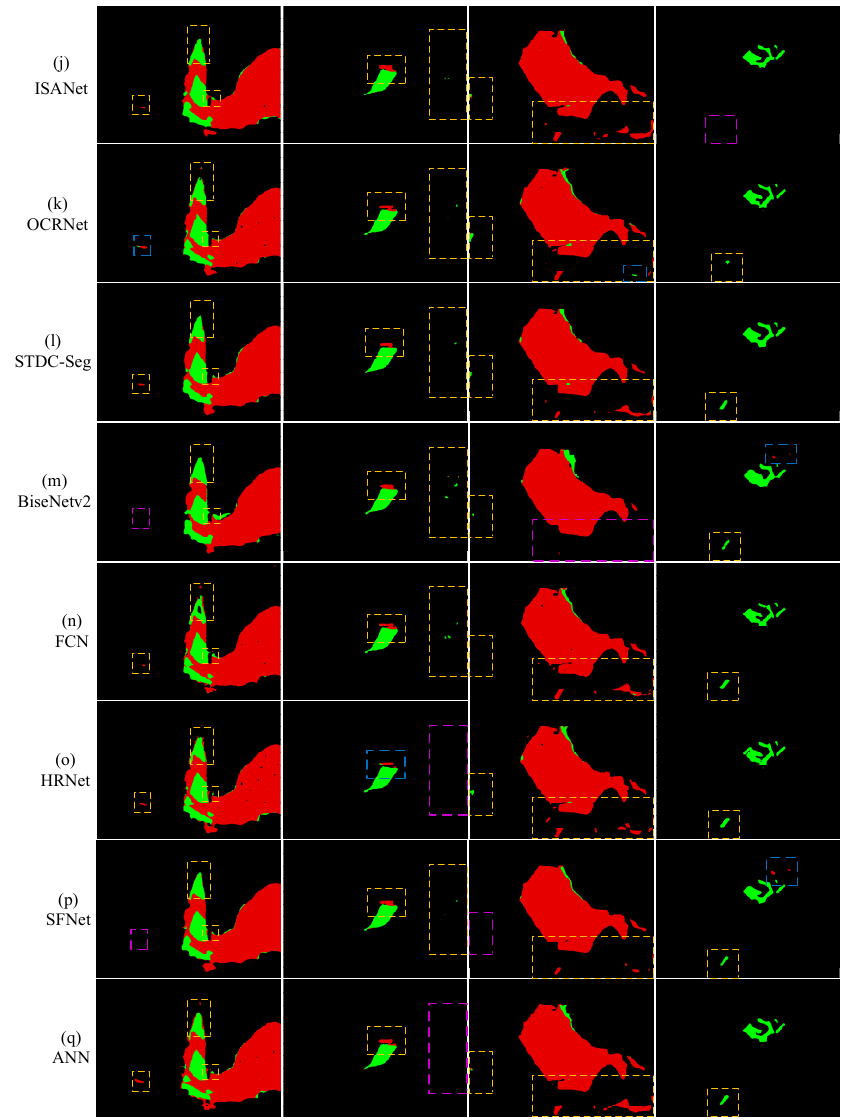
Figure 8. Network model prediction results: ( a ) 2DU 2 ‐ Net † ; ( b ) U 2 ‐ Net † ; ( c ) U ‐ Net; ( d ) PSPNet; ( e ) PFPNNet; ( f ) DeepLabV3; ( g ) DeepLabV3+; ( h ) DNLNet; ( i ) DANNet; ( j ) ISANet; ( k ) OCRNet; ( l ) STDC ‐ Seg ( m ) BiseNetv2; ( n ) FCN; ( o ) HRNet; ( p ) SFNet; ( q ) ANN.